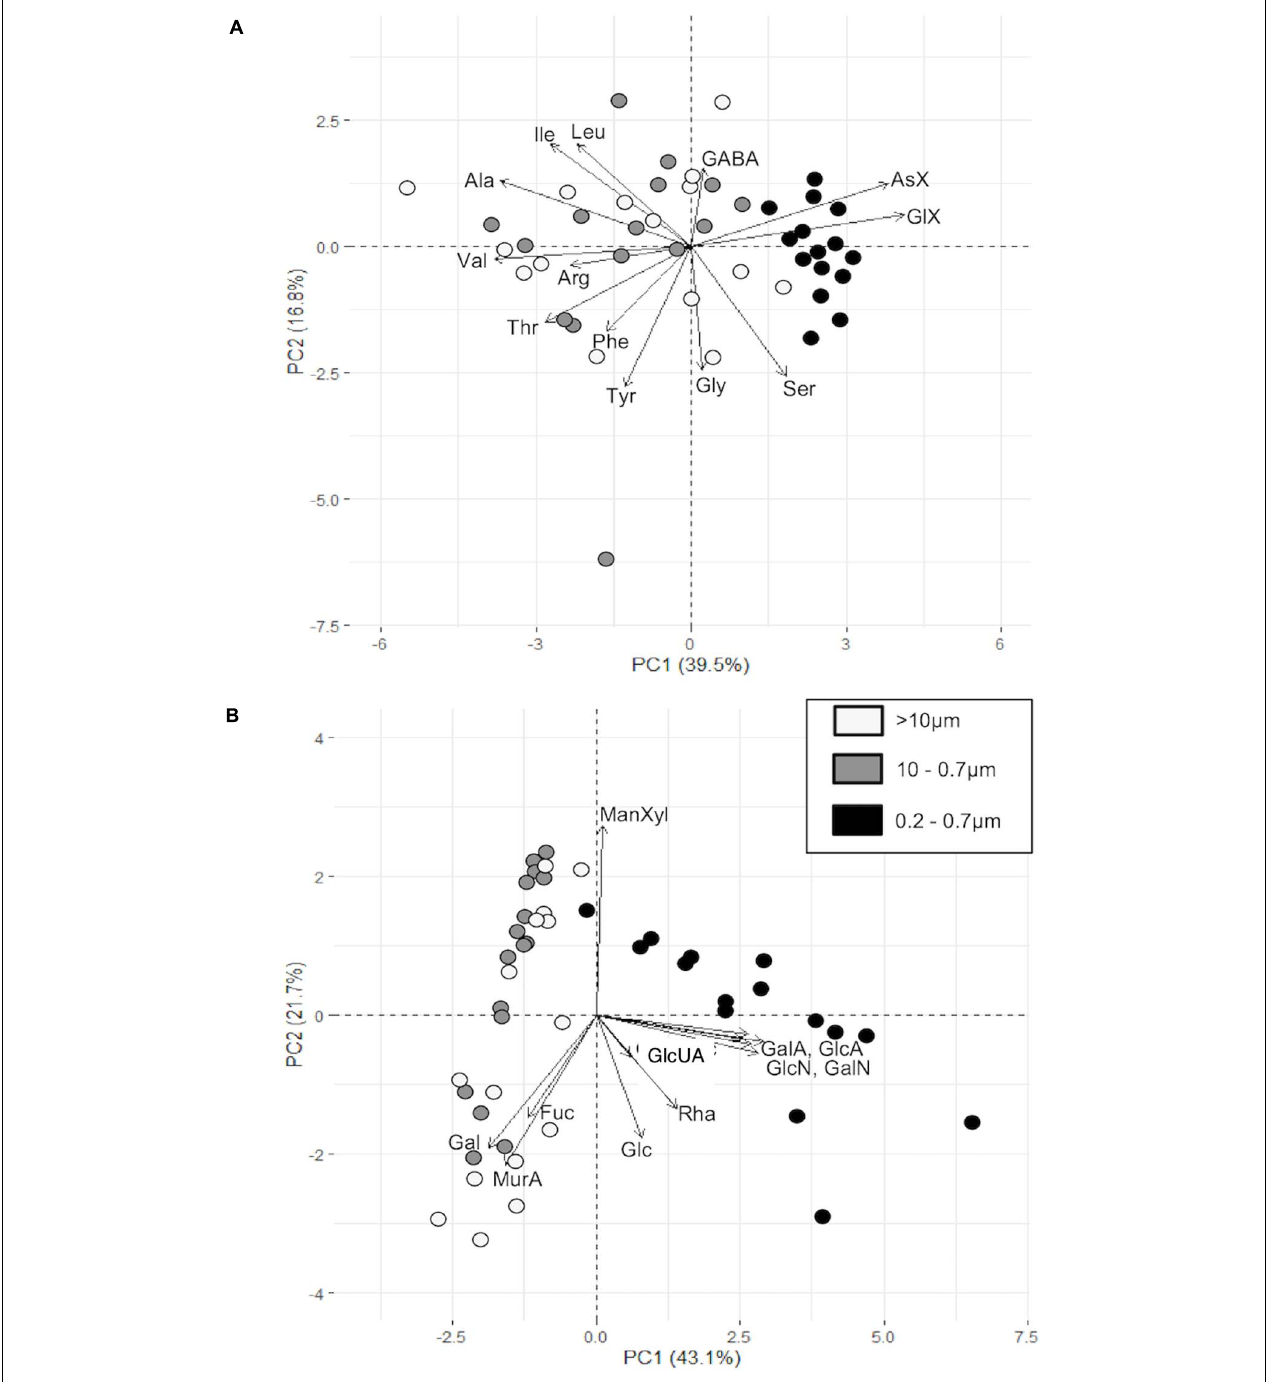
FIGURE 7 | PCA plot of different size fractions in PAA (A) and PCHO (B) .